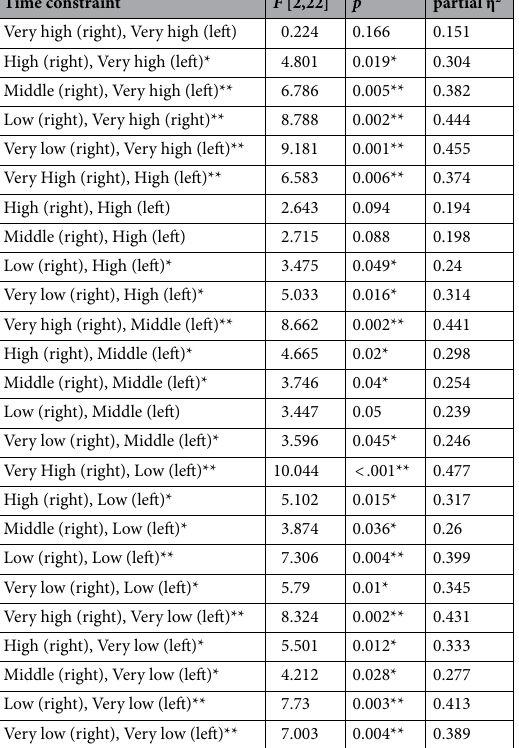
Table 1. One-way repeated-measures ANOVA (3 [cluster]) on the occurrence probability. *< 0.05, **<